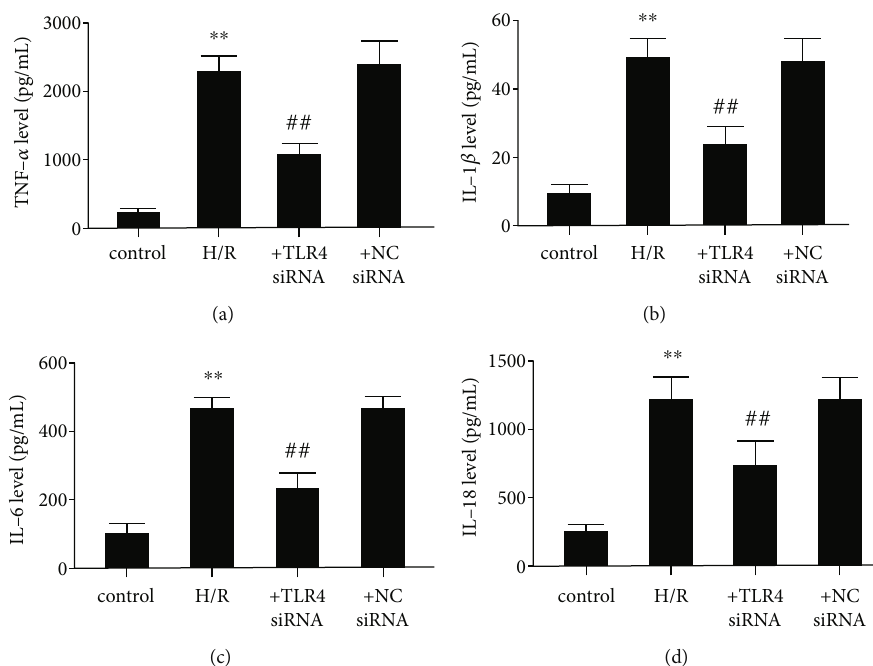
Figure 5: TLR4 knockdown inhibits in fl ammatory mediator release in H/R treated SH-SY5Y cells. (a) TNF- α level. (b) IL-1 β level. (c) IL-6 level. (d) IL-18 level. The data expressed as mean ± SD . ∗∗ P < 0 : 01 vs. control; ## P < 0 : 01 vs. H/R.